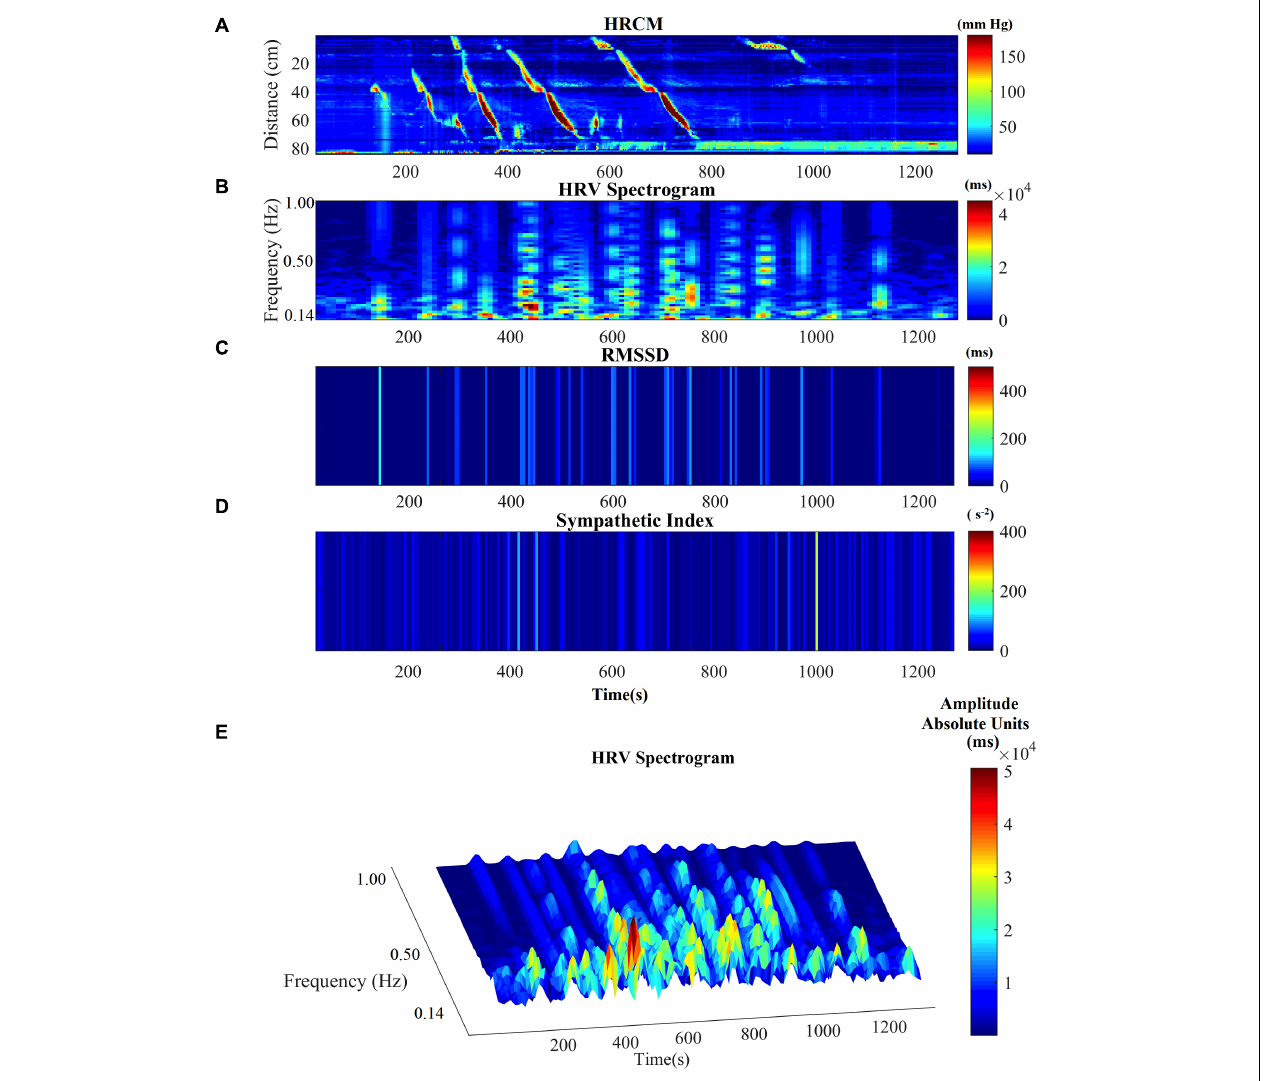
FIGURE 3 | HRV parameters associated with a complex of multiple HAPWs (a motor complex). (A) HRCM recording with a motor complex containing long overlapping HAPWs. (B) HF power/RSA band of HRV signal. (C) RMSSD. (D) SI. (E) HF/RSA power band in